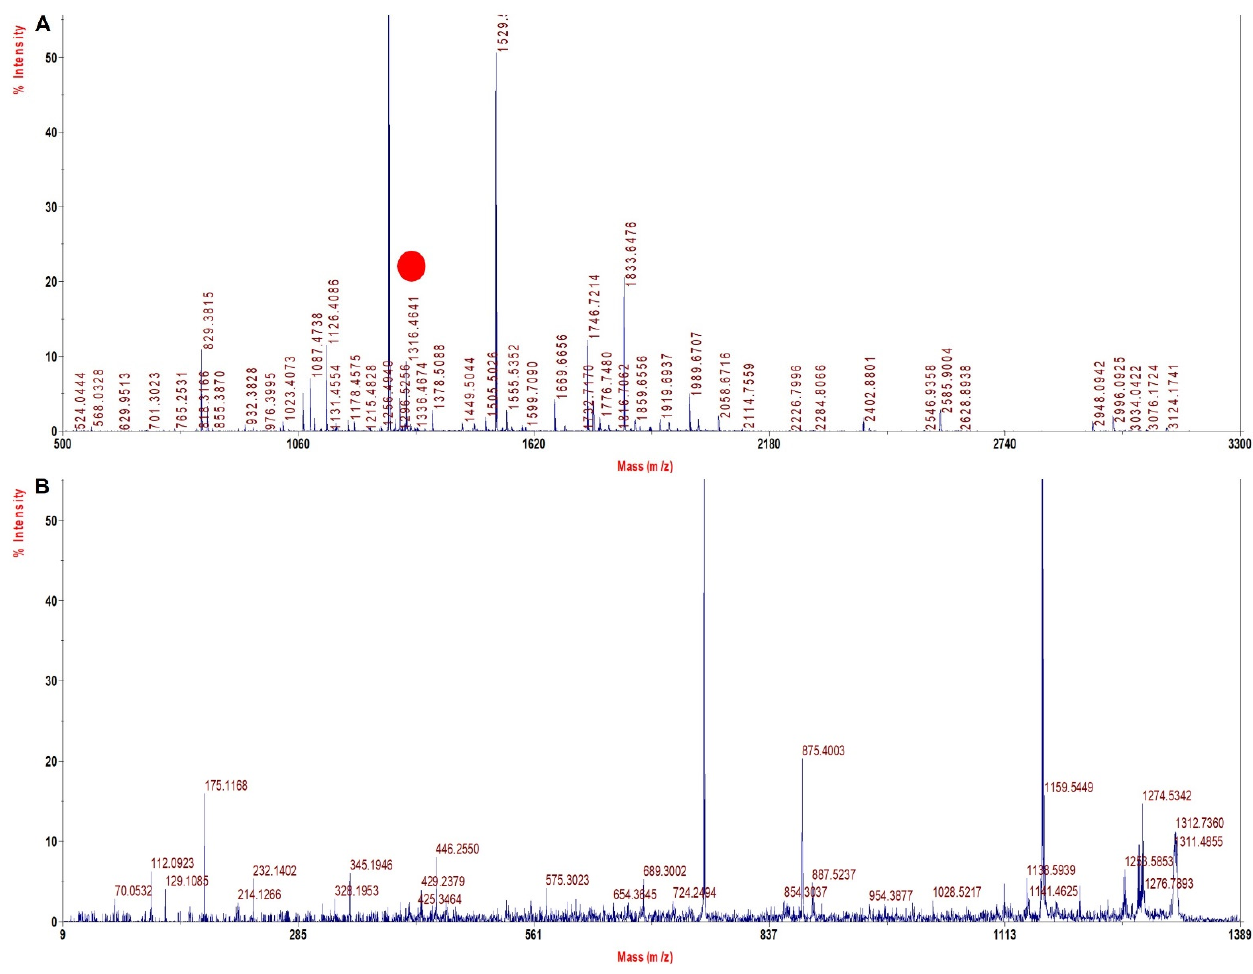
Figure 8. MALDI − MS and MALDI MS/MS spectra for the signature peptide from HbE (1963) Beta 26 (B8) Glu > Lys ( A ). PMF spectrum showing signature peptide obtained by TFE treated in − solution tryptic digestion. ( B ). MALDI − MS/MS spectrum of the signature peptide 1316.5 m/z of HbE sample.